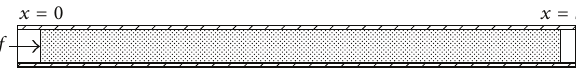
Figure 2: Mechanical model of the dense paste in pipeline.